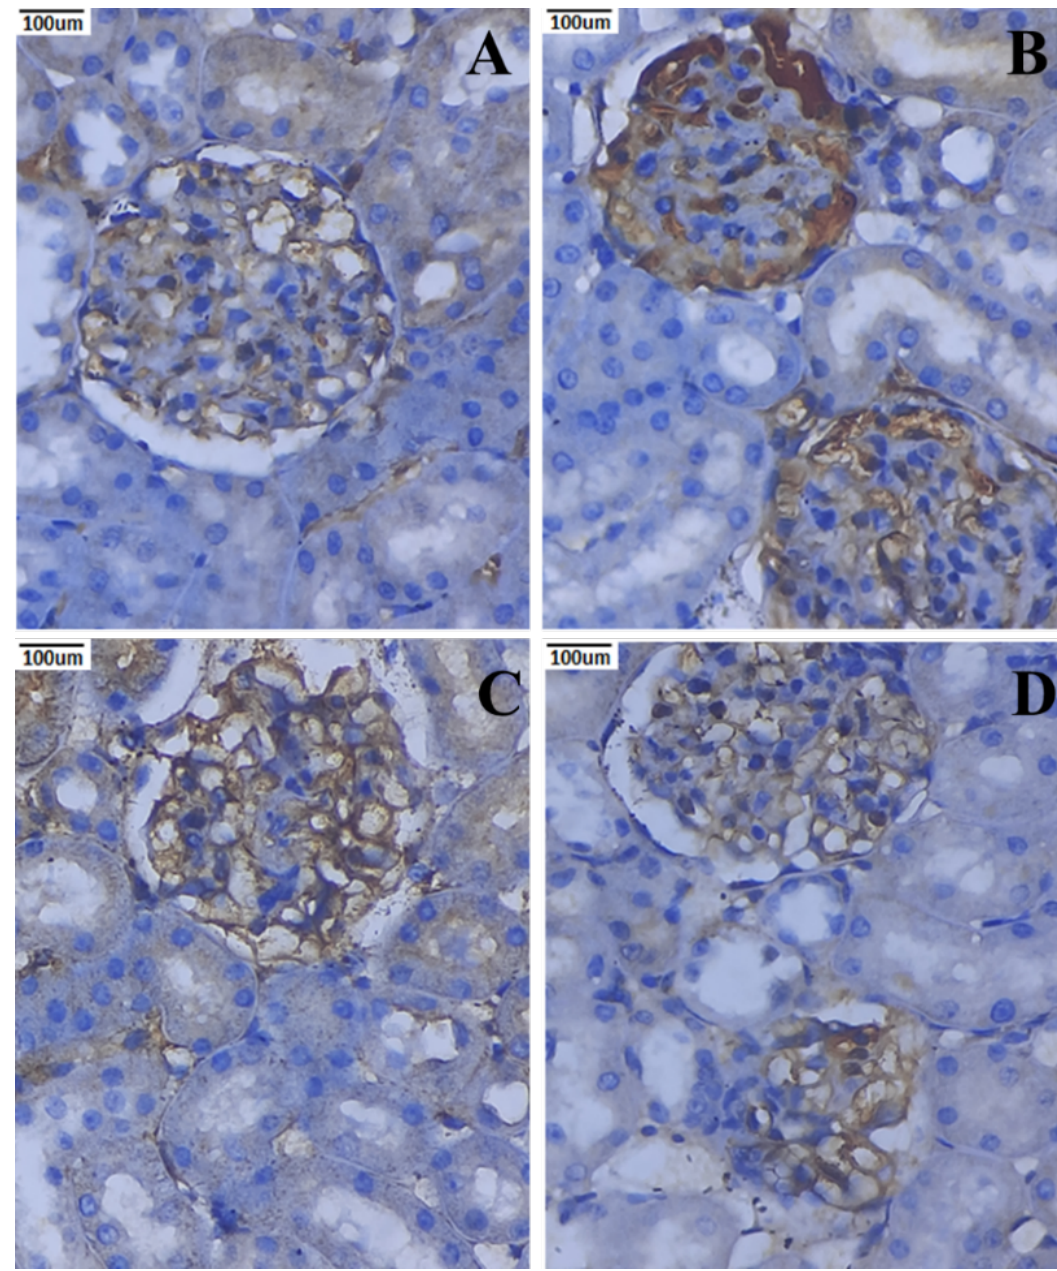
Figure 11. Activities of PCNPs on kidney TNF-α immunohistochemistry of DN rats (40×). ( A ) Control kidney shows a normal expression of glomerulus; ( B ) DN kidney indicates increased expression of TNF-α, showing that there is an increased mesangial cellularity red arrow; ( C ) STZ + 80 mg/kg of PCNP-treated kidney shows the near-normal appearance of mesangial cells and tubules; ( D ) 80 mg/kg of PCNPs only shows the normal expression of TNF-α in mesangial cells.